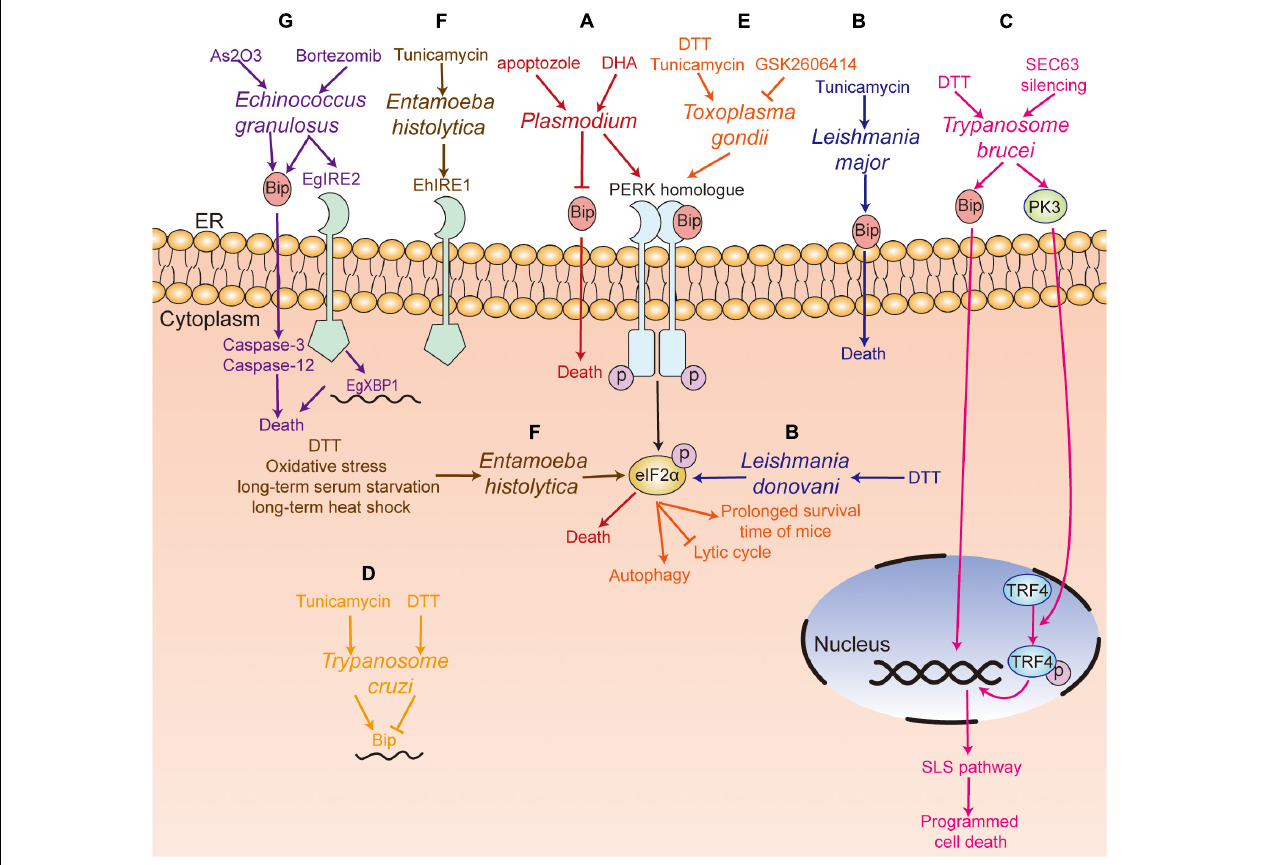
FIGURE 4 | UPR pathway in parasites. (A) Plasmodium spp. (red) with the PERK homolog; apoptozole was lethal to the chloroquine-sensitive and chloroquine-resistant P. falciparum parasite strains by inhibiting GRP78 function in vitro , and DHA treatment could induce the death of P. falciparum through the PERK-eIF2 α pathway; (B) Tunicamycin treatment induced the death of L. major (blue) with an increased level of Bip, and DTT treatment upregulated the phosphorylation of eIF2 α in L. donovani ; (C) DTT treatment induced programmed cell death. SEC63 silencing activated PK3, which further induced programmed cell death by phosphorylating TRF4 and inducing the SLS pathway in T. brucei (pink); (D) Tunicamycin treatment increased the level of Bip mRNA, while DTT treatment decreased the level of Bip in T. Cruzi (yellow); (E) GSK2606414 inhibited the lytic cycle of tachyzoites, including attachment/invasion, replication, egress, and prolonged the survival time of infected mice. DTT treatment mediated the apoptosis or autophagy of T. gondii (orange) by increasing the phosphorylation of TgIF2 α ; (F) DTT treatment, long-term serum starvation, long-term heat shock and oxidative stress induced the phosphorylation of eIF2 α , and the ortholog of IRE1 in E. histolytica (EhIre1) (gray) was identified; (G) Bortezomib treatment induced the death of E. granulosus (purple) with an increase of EgGRP78 and EgIRE2/EgXBP1 mRNA. Arsenic trioxide treatment induced the death of E. granulosus (purple) with upregulation of the expression of GRP78, caspase-3, and caspase-12 in protoscoleces. PERK, protein kinase RNA-like ER kinase; IRE1, inositol-requiring kinase/endoribonuclease 1; XBP1, X box-binding protein 1; Bip, immunoglobulin heavy chain binding protein; eIF2 α , α -subunit of eukaryotic translational initiation factor 2; TRF4, TBP-related factor 4; SLS pathway, spliced leader RNA silencing pathway; DTT, dithiothreitol; DHA,